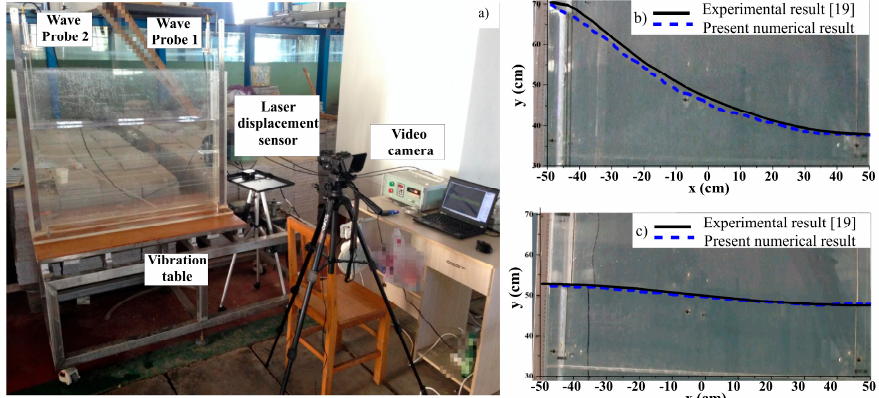
Figure 2. Free surface shape of sloshing water in a rectangular tank under horizontal harmonic excitation, ( a ) data acquisition system, ( b ) Resonant sloshing, ω / ω 1 = 0.996, ( c ) non-resonant sloshing, ω / ω 1 = 0.603.